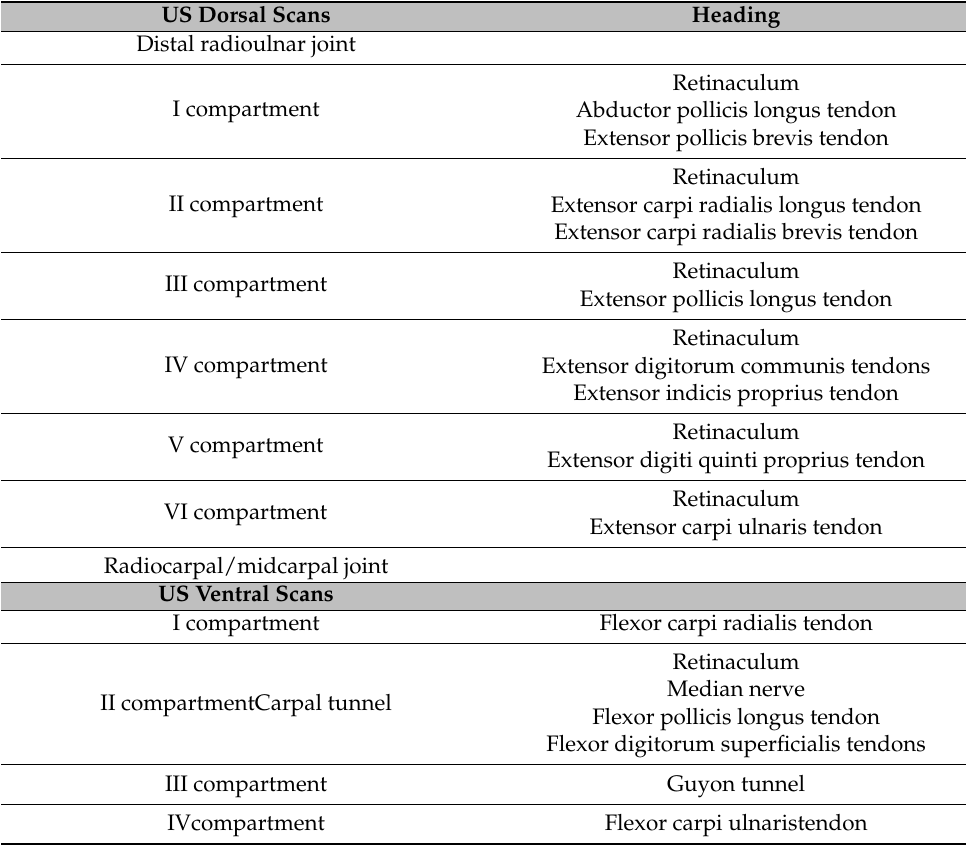
Figure 2. Hand Chart. Table 1. Acoustic windows of the dorsal and ventral wrist